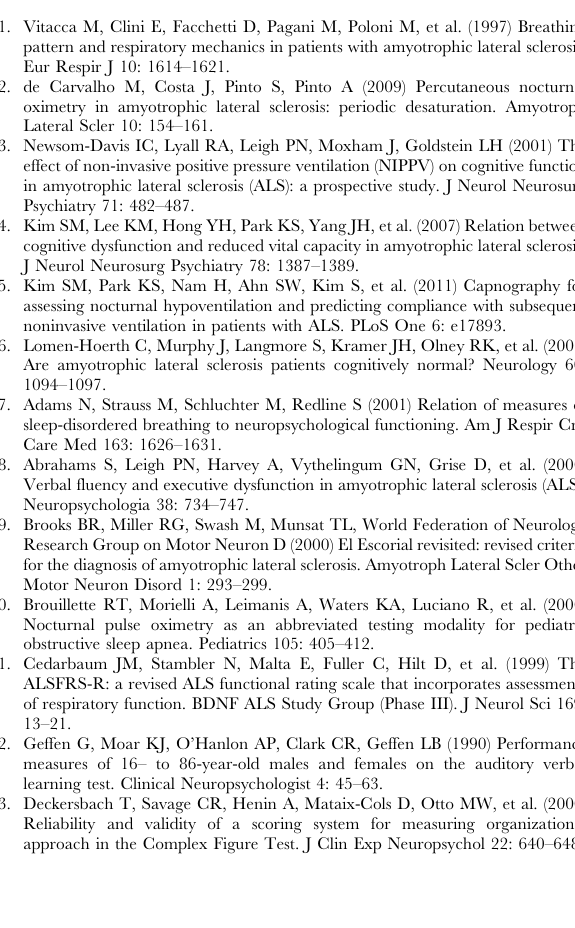
Figure S1 The retrieval efficiency in ALS patients correlated significantly with duration of nocturnal hypoxia (Spearman correlation analysis, rho= 2 0.458, p